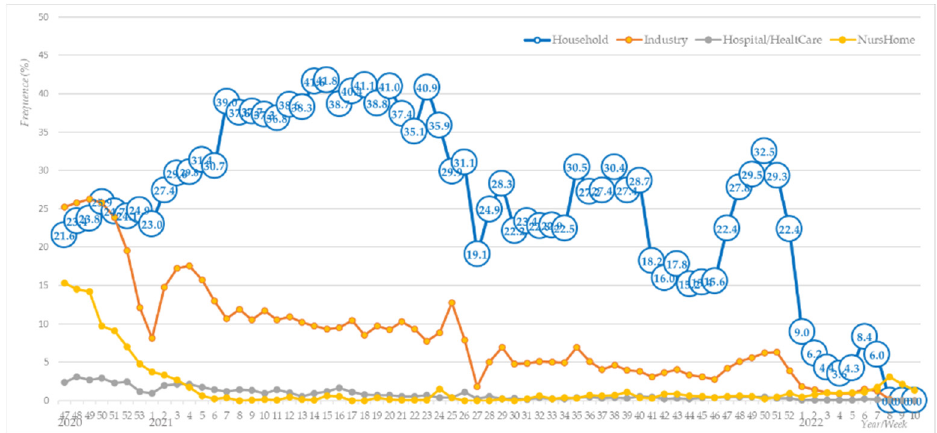
Figure 1. Weekly number of infections depending on the most probable location of virus